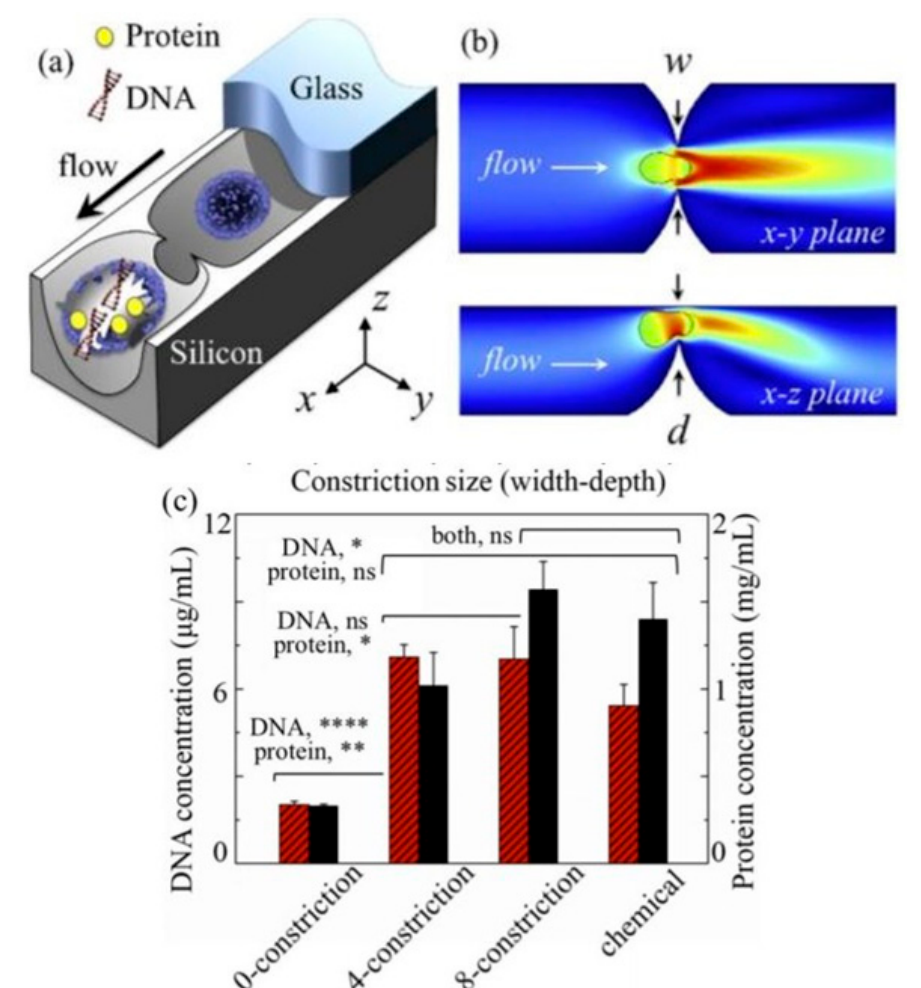
Figure 12. Single-cell point constriction utilized in [41] for reagent-free cell lysis. ( a ) Cell being ruptured by the ultra-sharp edge of a round constriction. ( b ) A cell undergoing excessive rapid deformation through a point constriction. ( c ) Comparison between the results of lysates obtained from a device without any constriction or from a conventional chemical method.